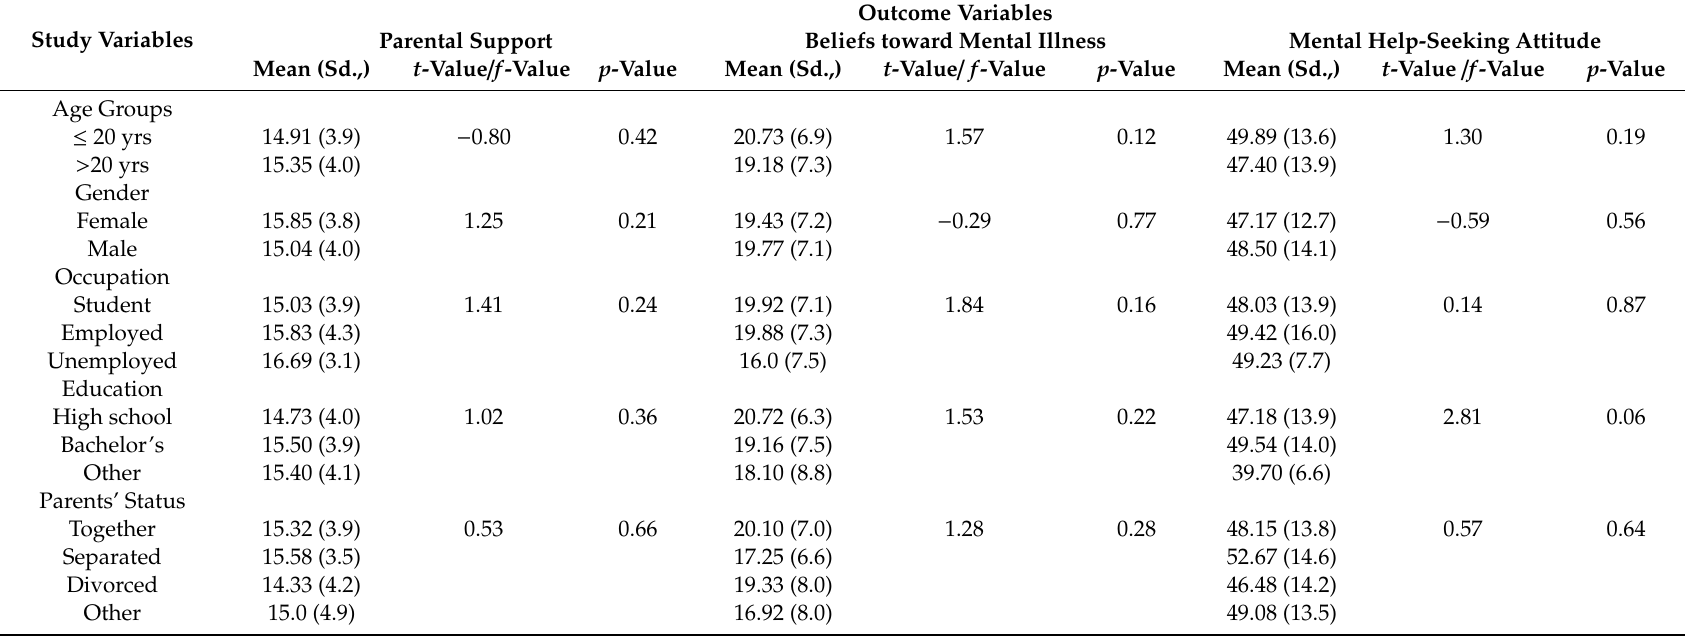
Table 3. Comparison of mean values of three outcome variables in relation to study demographic